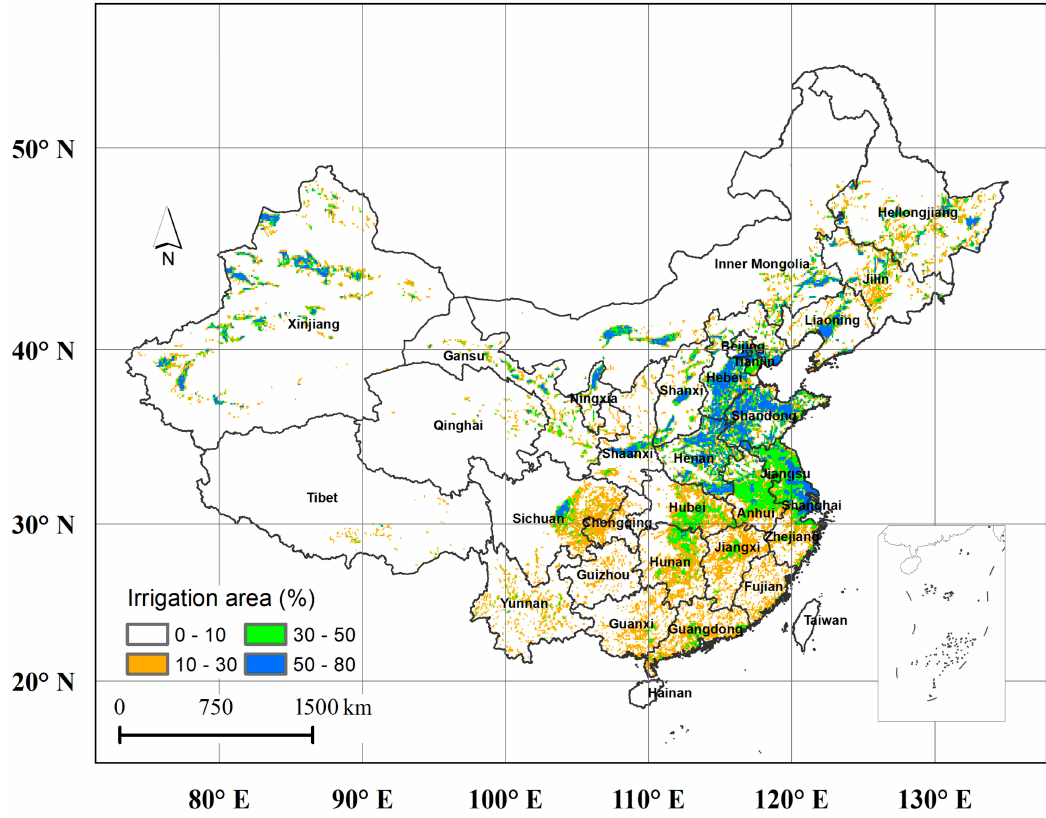
Figure 2. Gridded irrigation data based on the areas equipped for irrigation from FAOSTAT circa 2005.